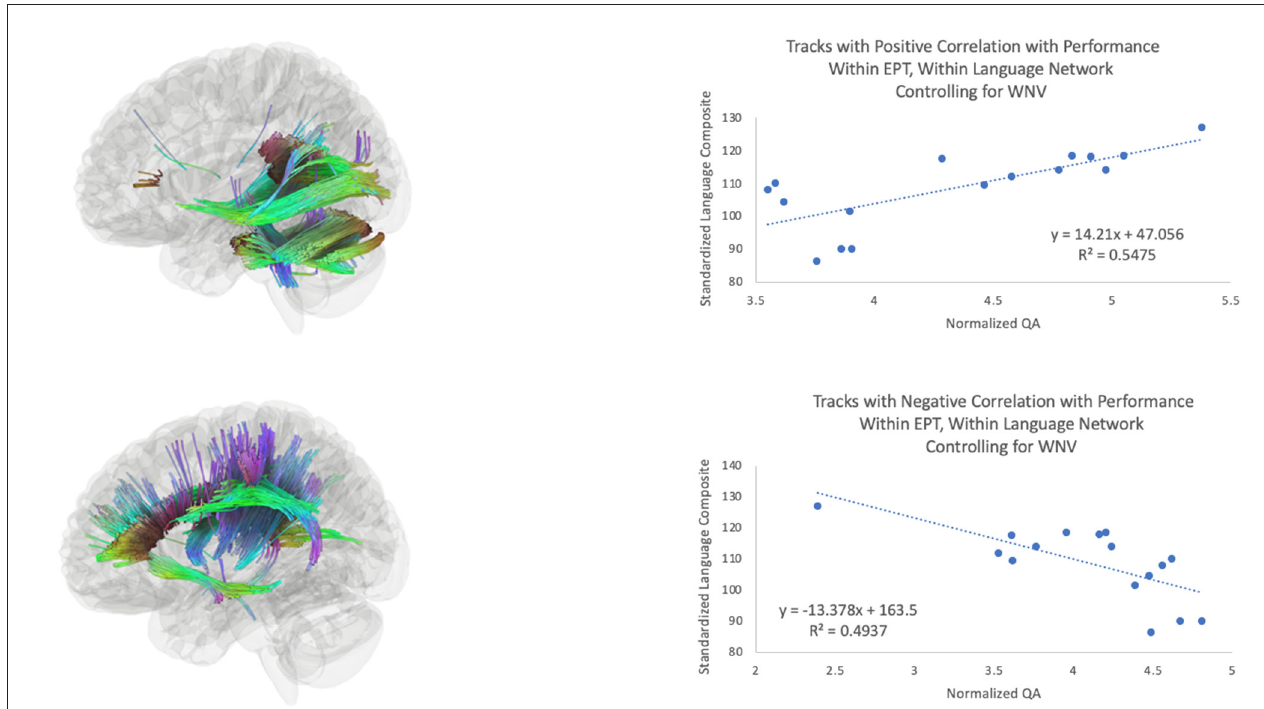
FIGURE 5 | Tracks positively associated (top) and negatively associated (bottom) with composite language performance within the EPT group. Scatterplots of language performance by normalized QA value within the tracts that were significant for the EPT group (see Figure 4 ) within the language network, for the analysis of the effects of language performance on white matter connectivity, controlling for